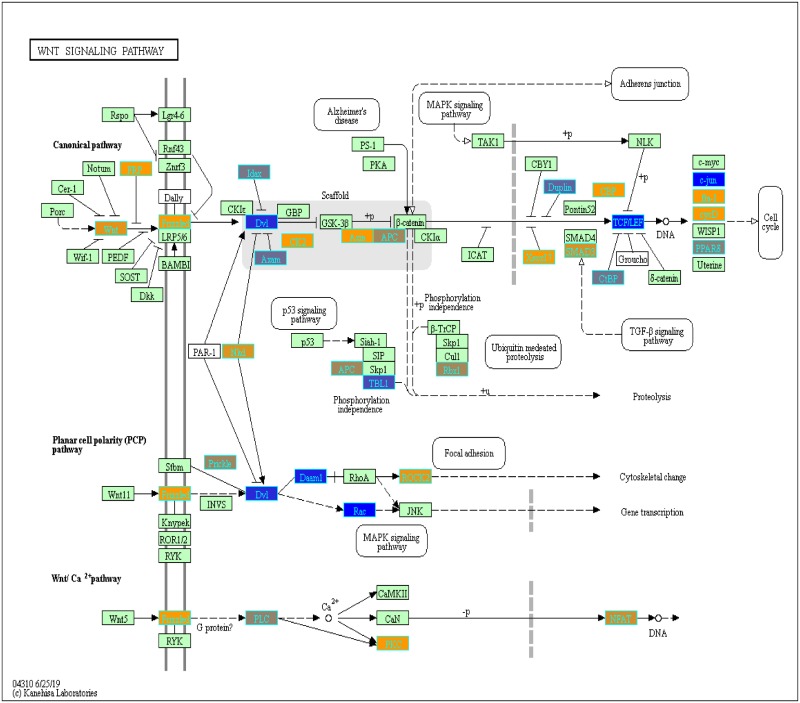
Highlighted Wnt signaling KEGG pathway (hsa04310) with enriched genes from the LRT (q-value < 0.05) [49–51].Yellow-colored genes are up-regulated and blue-colored genes are down-regulated in COPD samples.